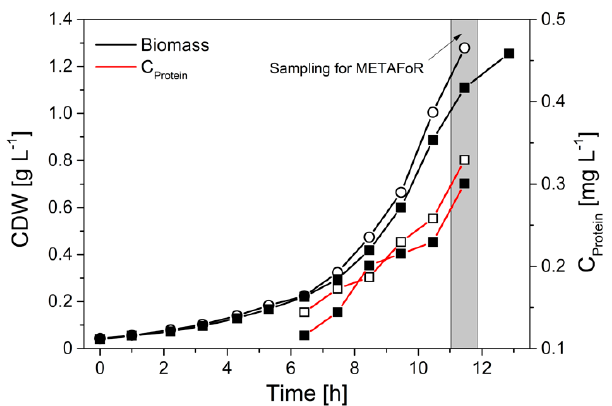
Figure 4. Growth of H. polymorpha RB11 conphys in aerobic batch culture with 5 g L − 1 100% (mol/mol) 1- 13 C glucose as sole carbon source. Biomass and extracellular protein from the cultivation supernatant were harvested for METAFoR in the late exponential growth phase.